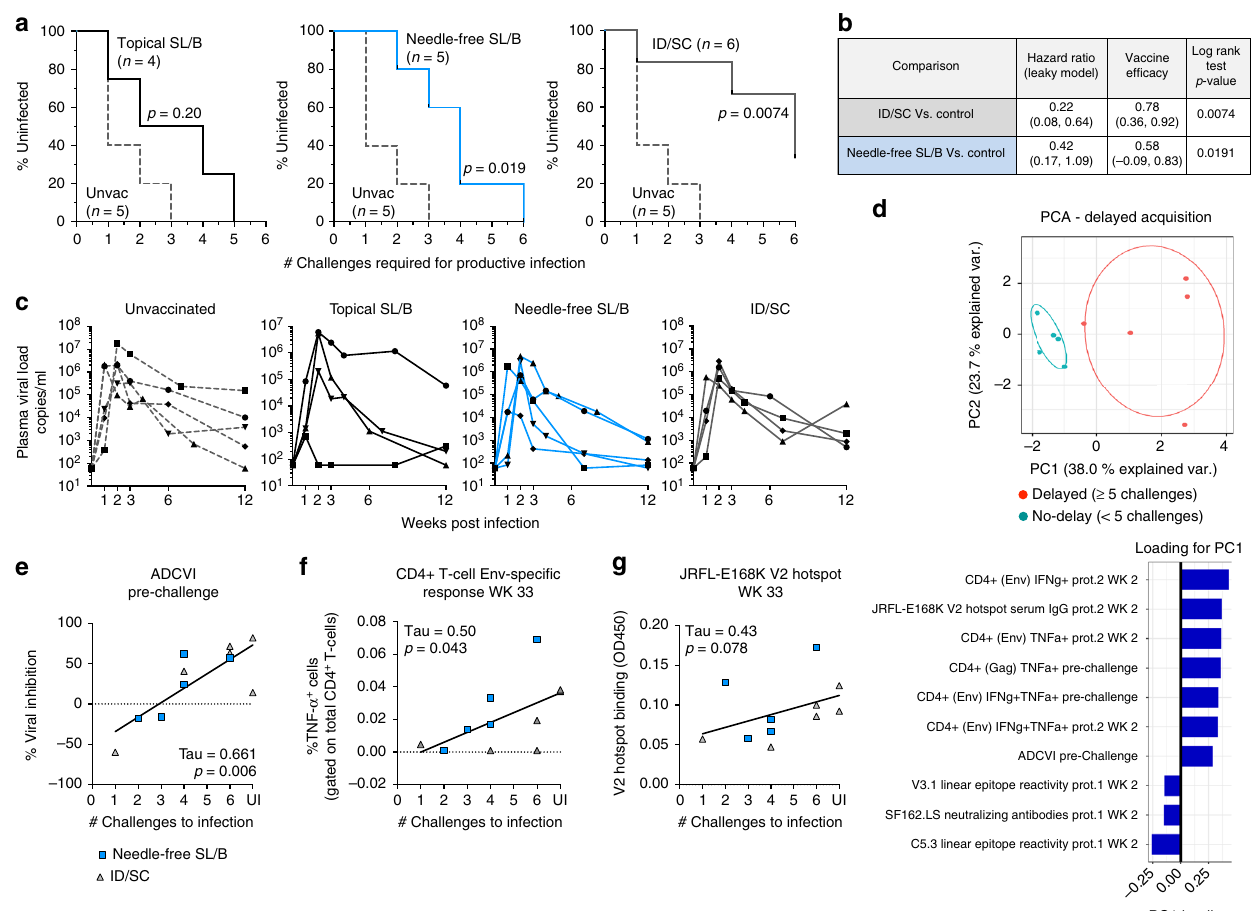
Fig. 6 Needle-Free SL/B and ID/SC immunization results in delayed acquisition of SHIV-SF162P3 infection. Animals were challenged weekly with an intra- rectal low dose (1:100 dilution) of SHIV-SF162P3. 5 unvaccinated macaques were used as a control. a Acquisition of infection in topical SL/B, needle-free SL/B, or ID/SC immunized animals (Log-rank (Mantel-Cox) test). Dotted line, unvaccinated controls ( n = 5); black line, topical SL/B ( n = 4); blue line, needle-free SL/B ( n = 5); gray line, ID/SC ( n = 6). b Vaccine ef fi cacy of ID/SC, needle-free SL/B immunization groups vs control animals (Log-rank (Mantel-Cox) test). c Kinetics of plasma viral loads in unvaccinated and vaccinated animals. d Top, Principal Comparison Analysis (PCA) plot showing PC1 and PC2 scores for delayed ( ≥ 5 challenges to infect, n = 5) or non-delayed (<5 challenges to infect, n = 6) acquisition of infection in needle-free SL/B and ID/SC immunized animals. Bottom, loadings of immune response parameters in PC1. e - g Correlation analysis of ADCVI activity at pre-challenge, Env- speci fi c CD4 + T cell TNF- α production two weeks after the second cycP-gp120 immunization (wk 33), and JRFL-E168K V2 hotspot reactivity in serum IgG (wk 33) with acquisition of infection. (Kendall ’ s Tau Correlation Test). Needle-free SL/B (blue squares) and ID/SC (gray triangles) are combined